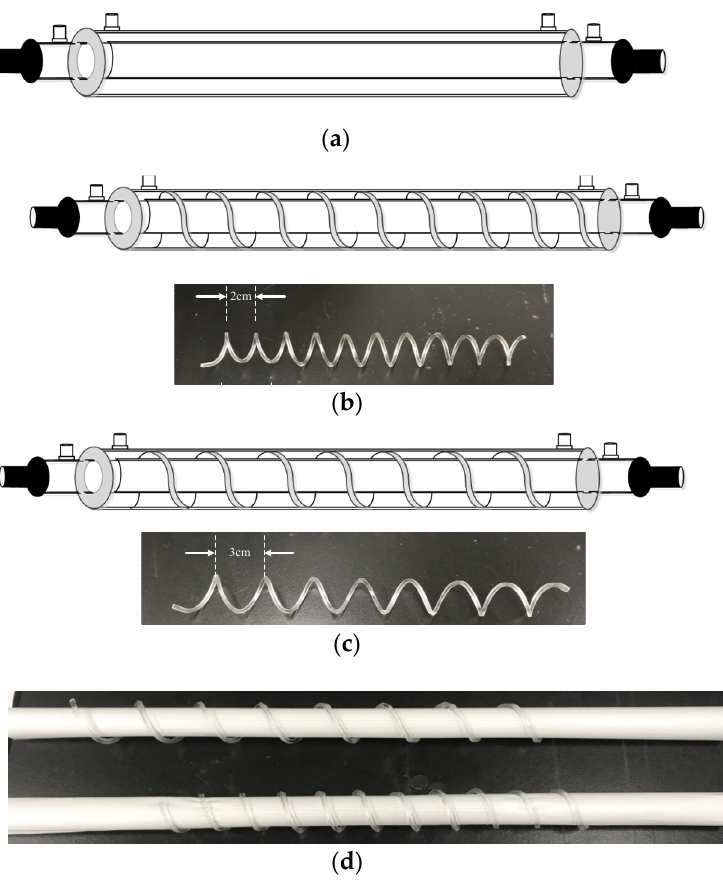
Figure 5. Components of concentric circular membrane contactors for the empty channel and two spiral-wire pitches of spiral wired annulus channel. ( a ) Empty channel; ( b ) 2 cm spiral-wire pitch; ( c ) 3 cm spiral-wire pitch; ( d ) Membrane tube with 2 cm and 3 cm spiral-wire pitches.